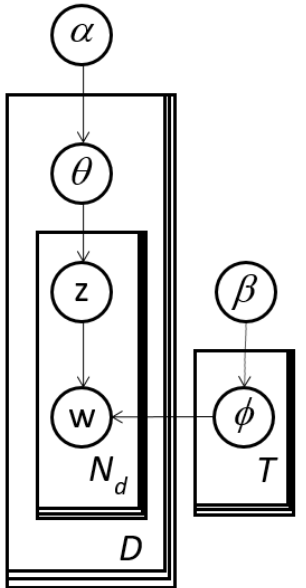
Figure 4. LDA expressed as a graphical model. It is equivalent to the distribution definition in Equation (1).